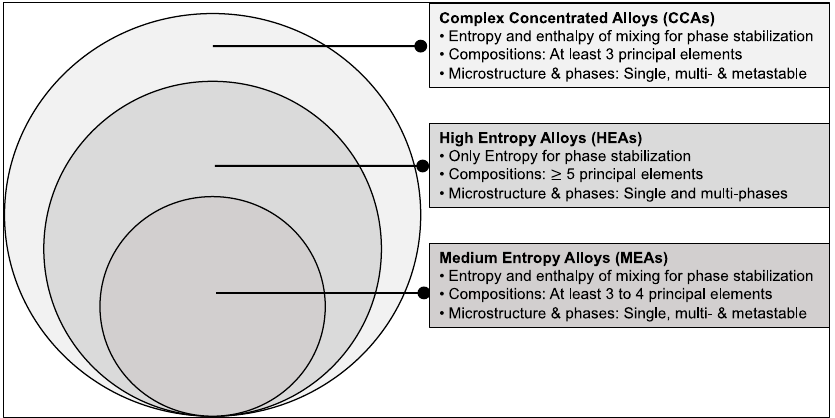
Coatings 2023 , 13 , x FOR PEER REVIEW Figure 8. Complex concentrated alloys and their derivatives. Figure 8. Complex concentrated alloys and their derivatives.